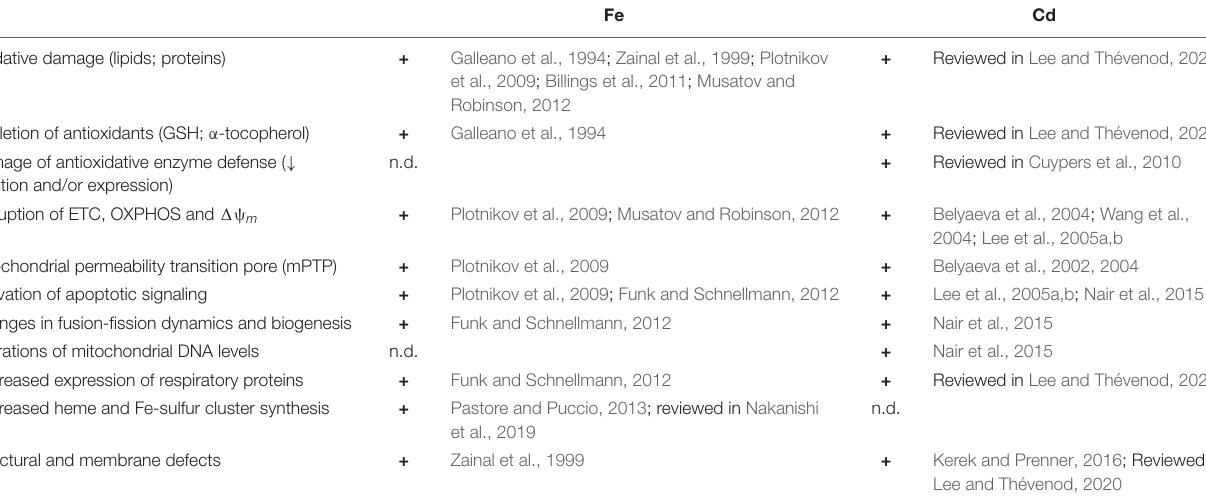
TABLE 1 | Key alterations of mitochondrial structure, function and expression elicited by increased mitochondrial Fe and Cd transport. Fe